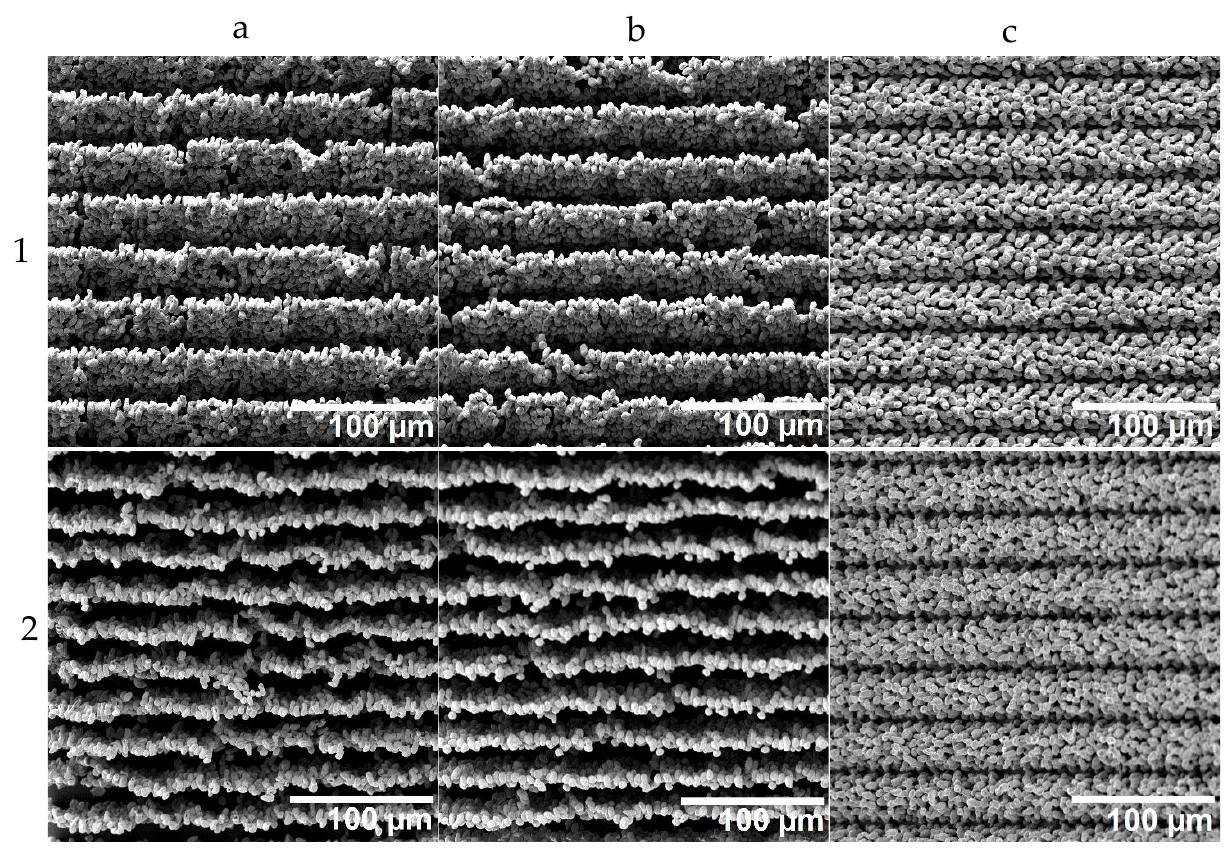
Figure 7. Scanning electron microscopy (SEM) images of structures obtained with different printing strategies ( a – c ) corresponding to the printing strategies a, b and c illustrated in Figure 3. The SEM micrographs in row 1 show top views, while the SEM micrographs in row 2 show views with a tilt of 45 ◦ . Columns ( a – c ) correspond to the three different printing strategies sketched in Figure